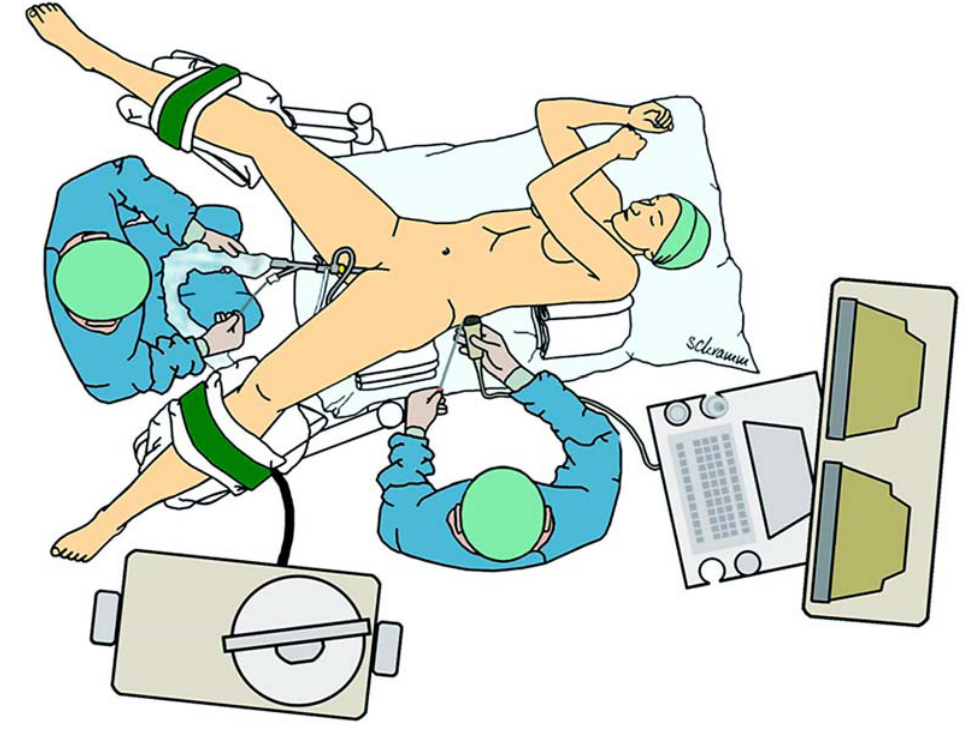
Figure 1 – Patient position on the table with both transurethral and percutaneous